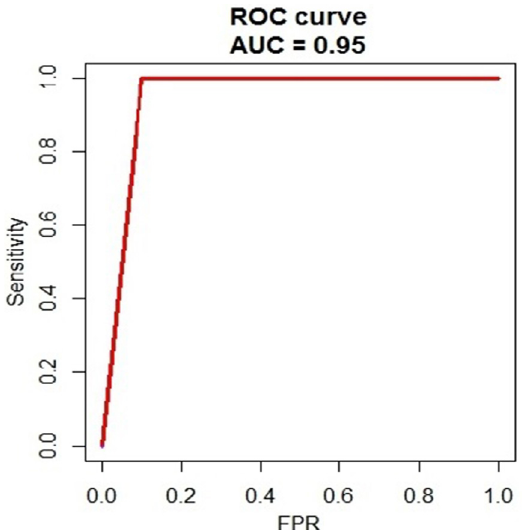
Fig. 3. ROC curves of the proposed method before applying the gene selection process for sample size of 20.